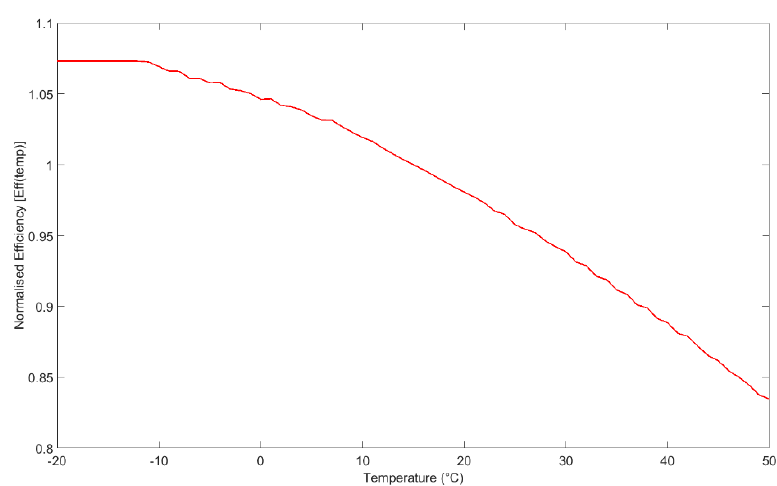
Figure 3. Normalized E fficiency v s . T emperature curve. (source: [21]).